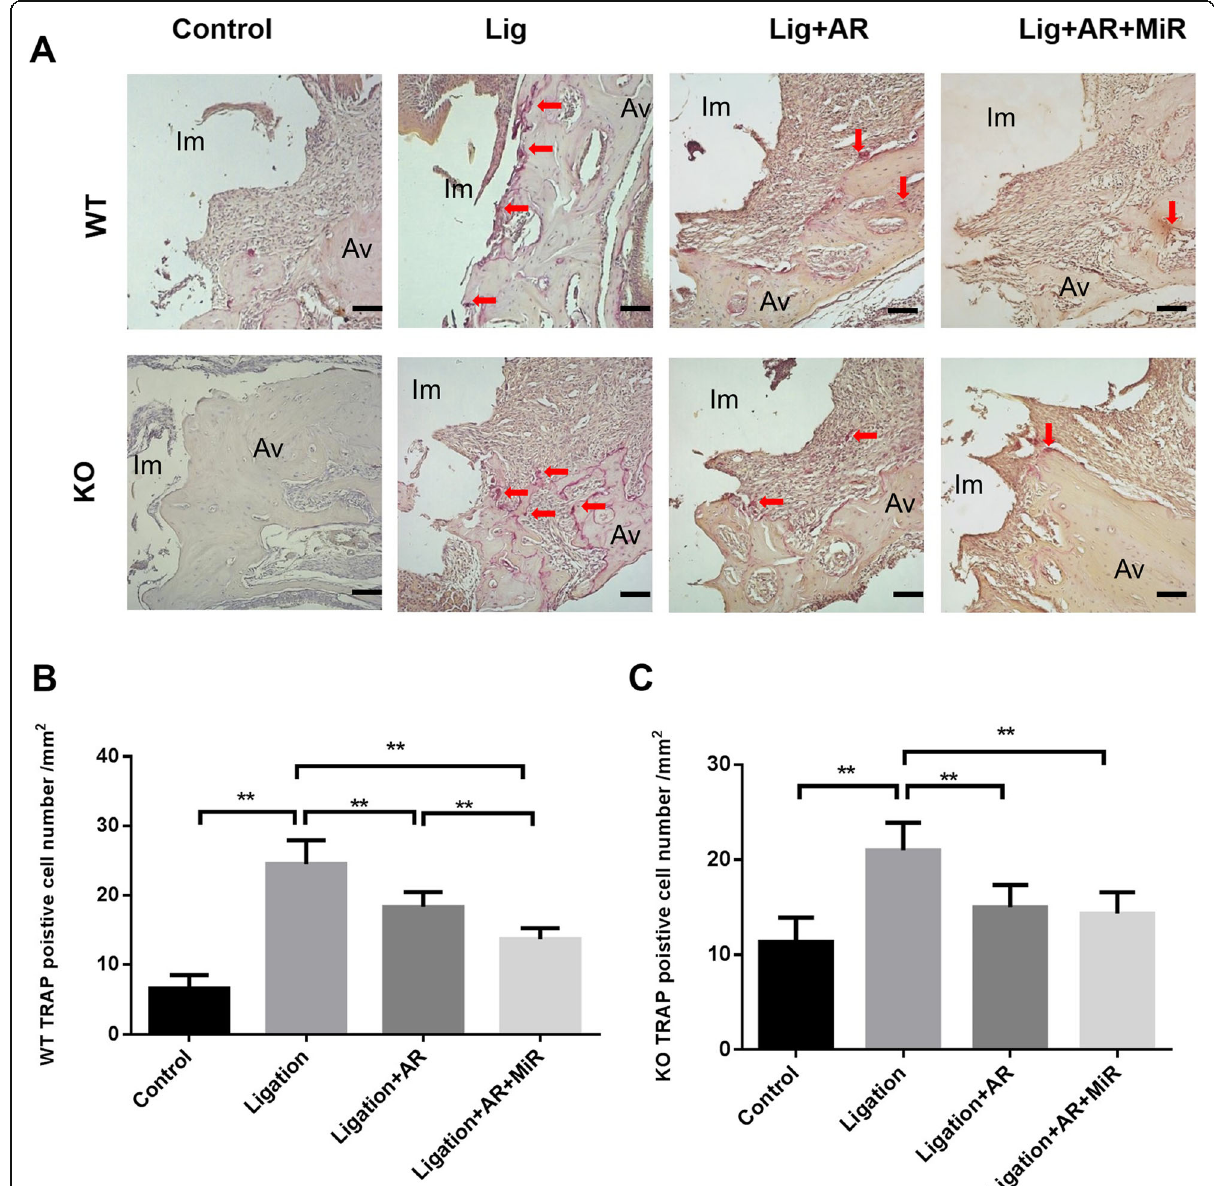
Fig. 3 Anti-RANKL and anti-RANKL+miR-146a treatments decreased TRAP-positive cell quantities with different patterns in experimental peri- implantitis of WT and TLR2/4 KO mice. TRAP-positive cells (red color) with 3 or more nuclei were considered osteoclasts and were shown in the control group, ligation group, ligation with anti-RANKL antibody treatment group, and ligation with anti-RANKL antibody + miR-146a treatment group in WT mice and TLR2/4 KO mice ( a ) (Im, implant; Av, alveolar bone; scale bar, 100 μ m). The quantities of TRAP-positive cells were analyzed in each group of WT mice ( b ) and TLR2/4 KO mice ( c ) (mean ± SD, n = 6, ** p <